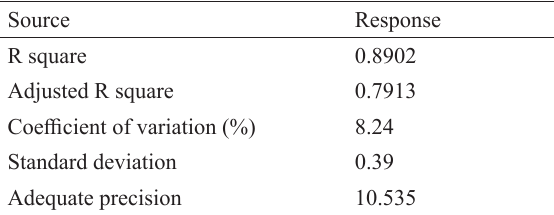
Statistical information of the